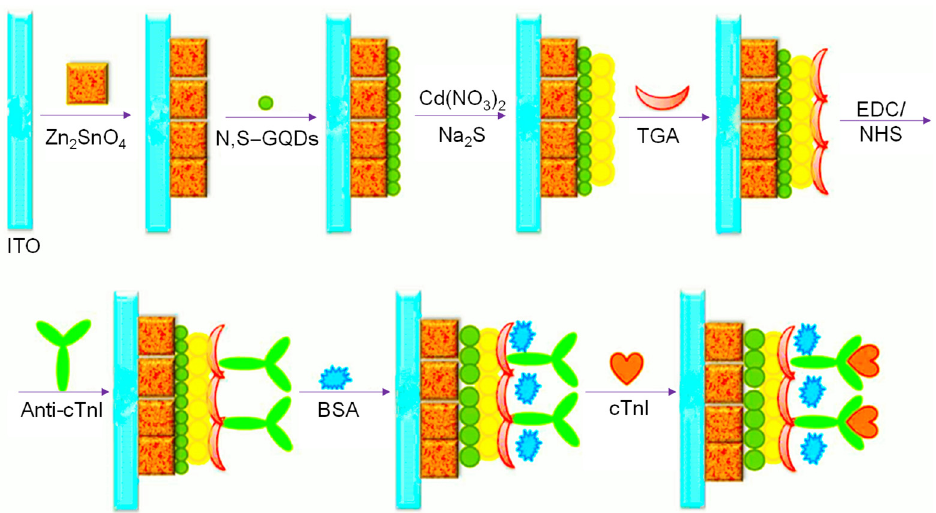
Figure 28. Fabrication of an N,S-GQD-based photoelectrochemical (PEC) antibody-sensor for cTnI monitoring [353].